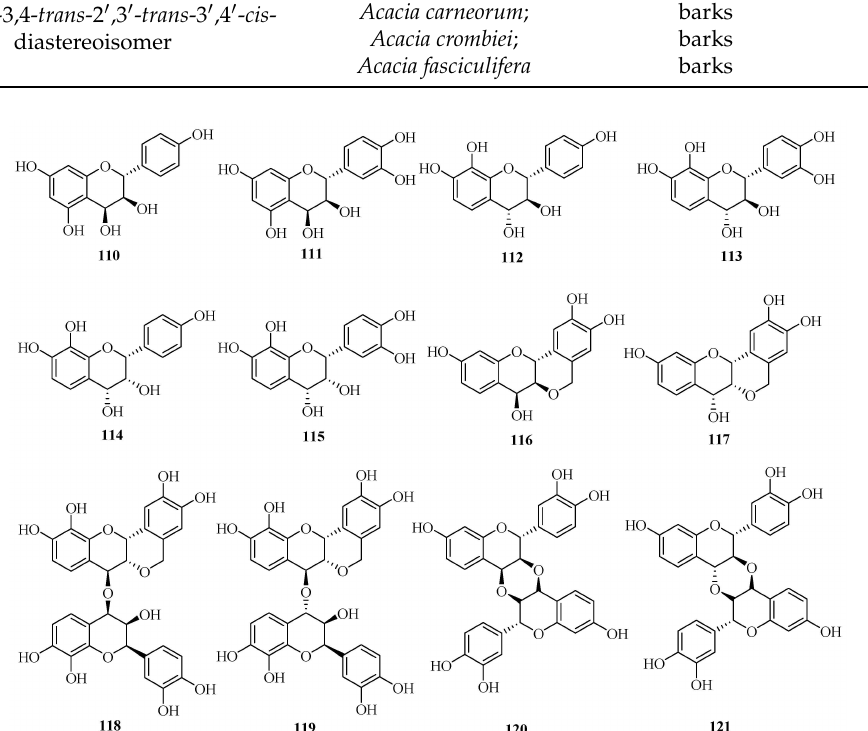
Figure 6. Structures of